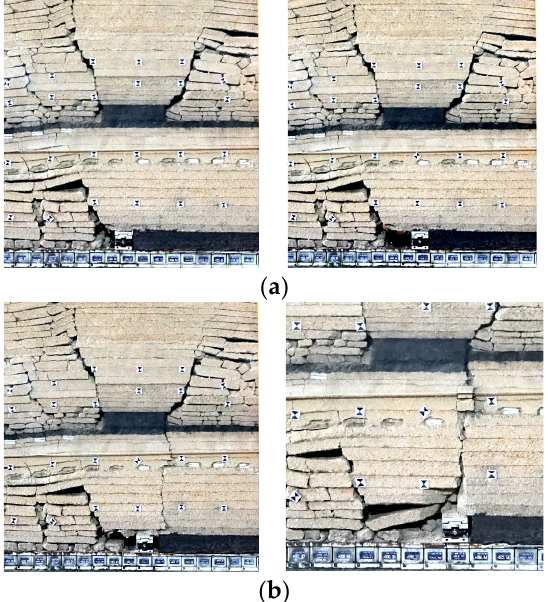
Figure 13. Strong ground pressure passing the coal pillar mining: ( a ) Normal period weighting under the coal pillar. ( b ) Interburden is cutting, the working face support is crushing.